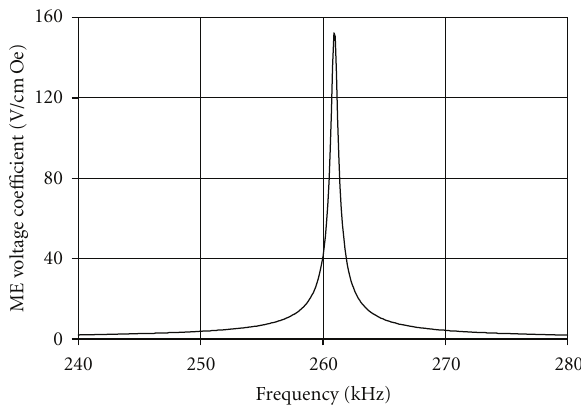
Figure 12: Frequency dependence of α E ,13 for the bilayer of CFO and PZT with length of 7.3 mm and PZT volume fraction